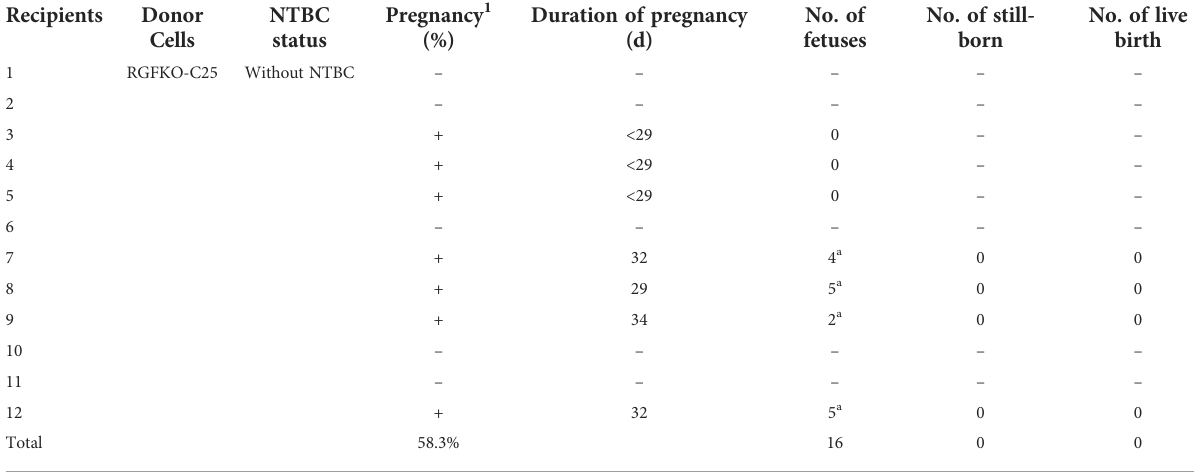
TABLE 2 Summary of the generation of RGFKO pigs by somatic cell nuclear transfer in sows without NTBC supplementation (Group A).